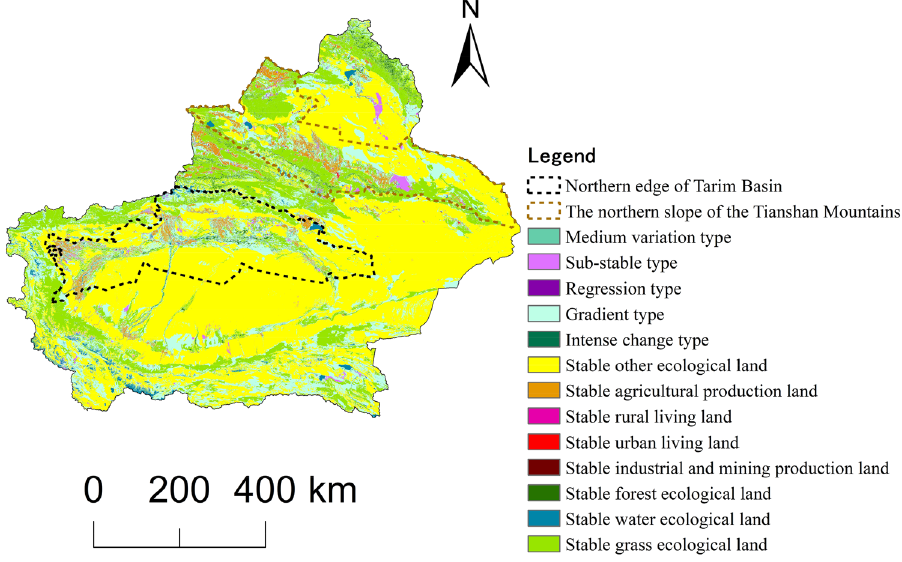
Figure 5. Types of land use change trajectories in Xinjiang from 1980 to 2020. Map generated with ArcGIS 10.8 (ESRI). URL: https:// suppo rt. esri. com/ en/ Produ cts/ Deskt op/ arcgis- deskt op/ arcmap.